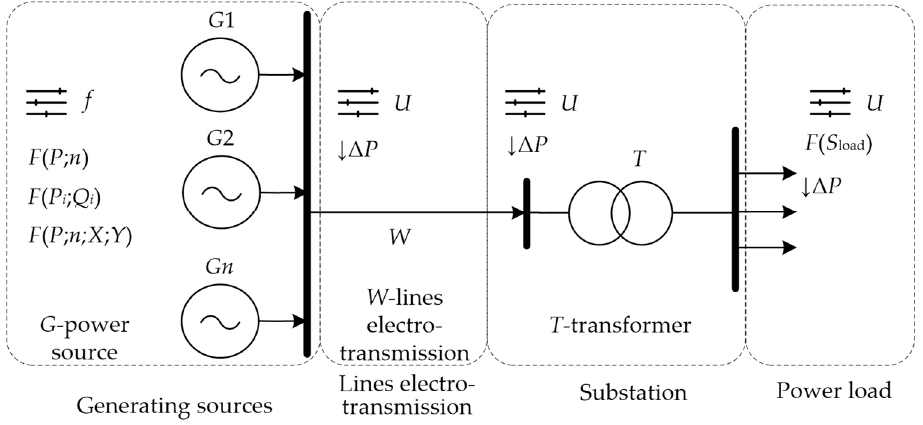
Figure 1. Optimized condition parameters in electric power systems and networks.